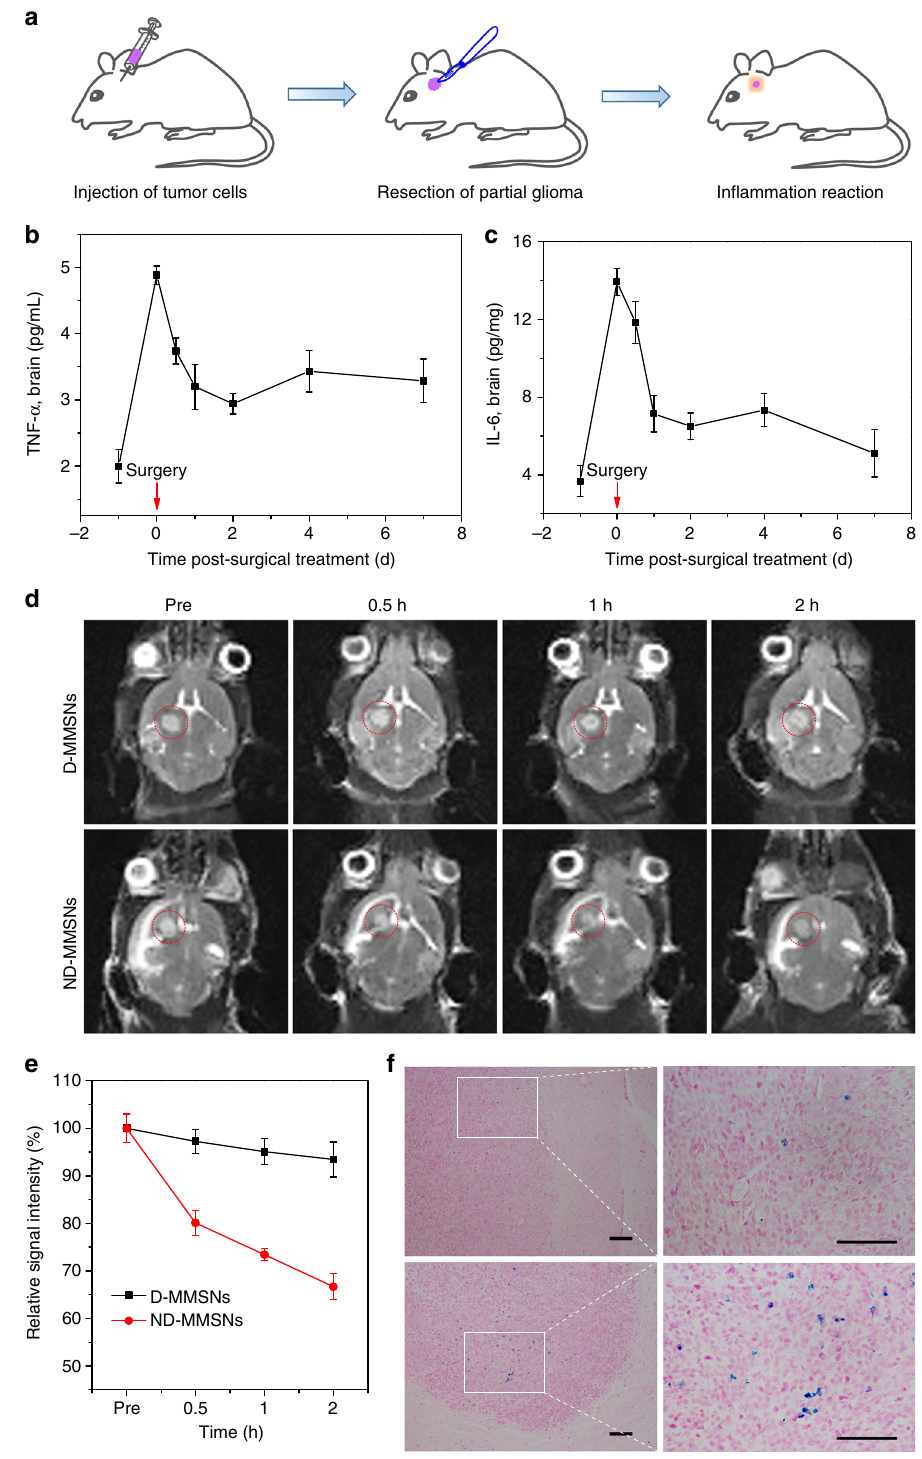
Fig. 4 In vivo T 2 -weighted MR imaging. a Schematic representation of in vivo in fl ammation reaction after resecting partial glioma. Evaluation of the in fl ammation cytokines TNF- α ( b ) and IL-6 ( c ) levels in the brain of the U87-bearing mice after surgical treatment for 7 d. d In vivo T 2 -weighted MR images of postsurgical glioma-bearing mice before and after intravenous injection of D-MMSNs and ND-MMSNs. The red circles point to the tumor site. e Relative signal intensities of postsurgical glioma as a function of time. f Histological analysis of brain tissues by Prussian blue staining. Scale bar: 50 μ m. Mean values and error bars are de fi ned as mean and s.d., respectively ( n =